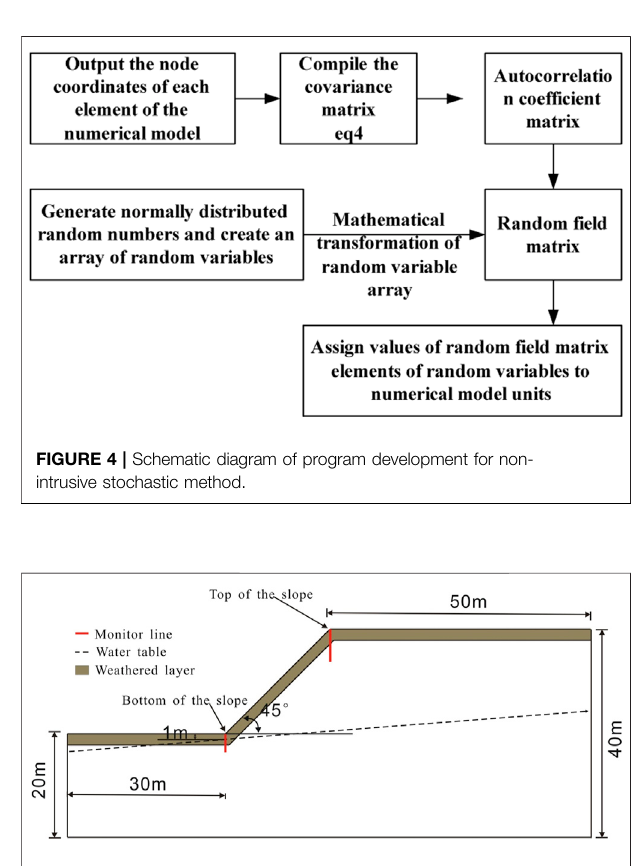
FIGURE 5 | Slope geometry and boundary